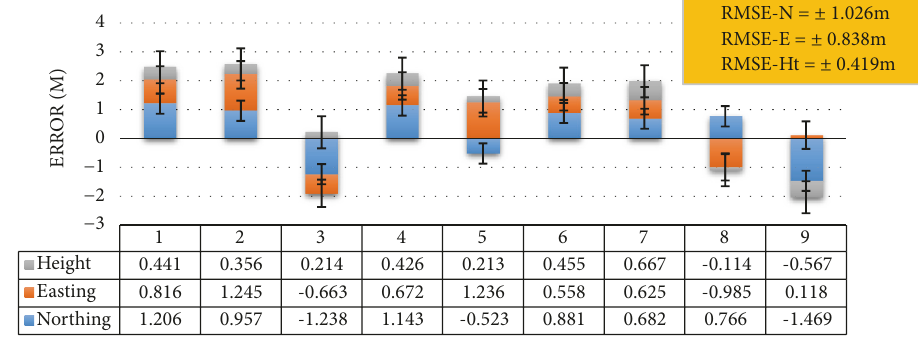
Figure 10: Error and RMSE results for northing, easting, and height coordinates.